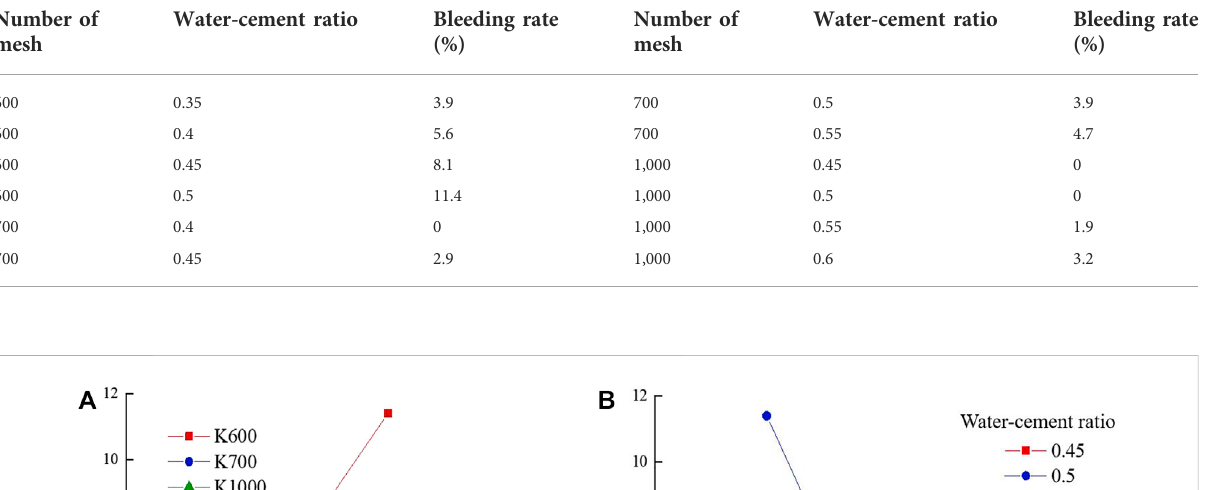
TABLE 6 Bleeding rate of super fi ne cement with different water-cement ratio.